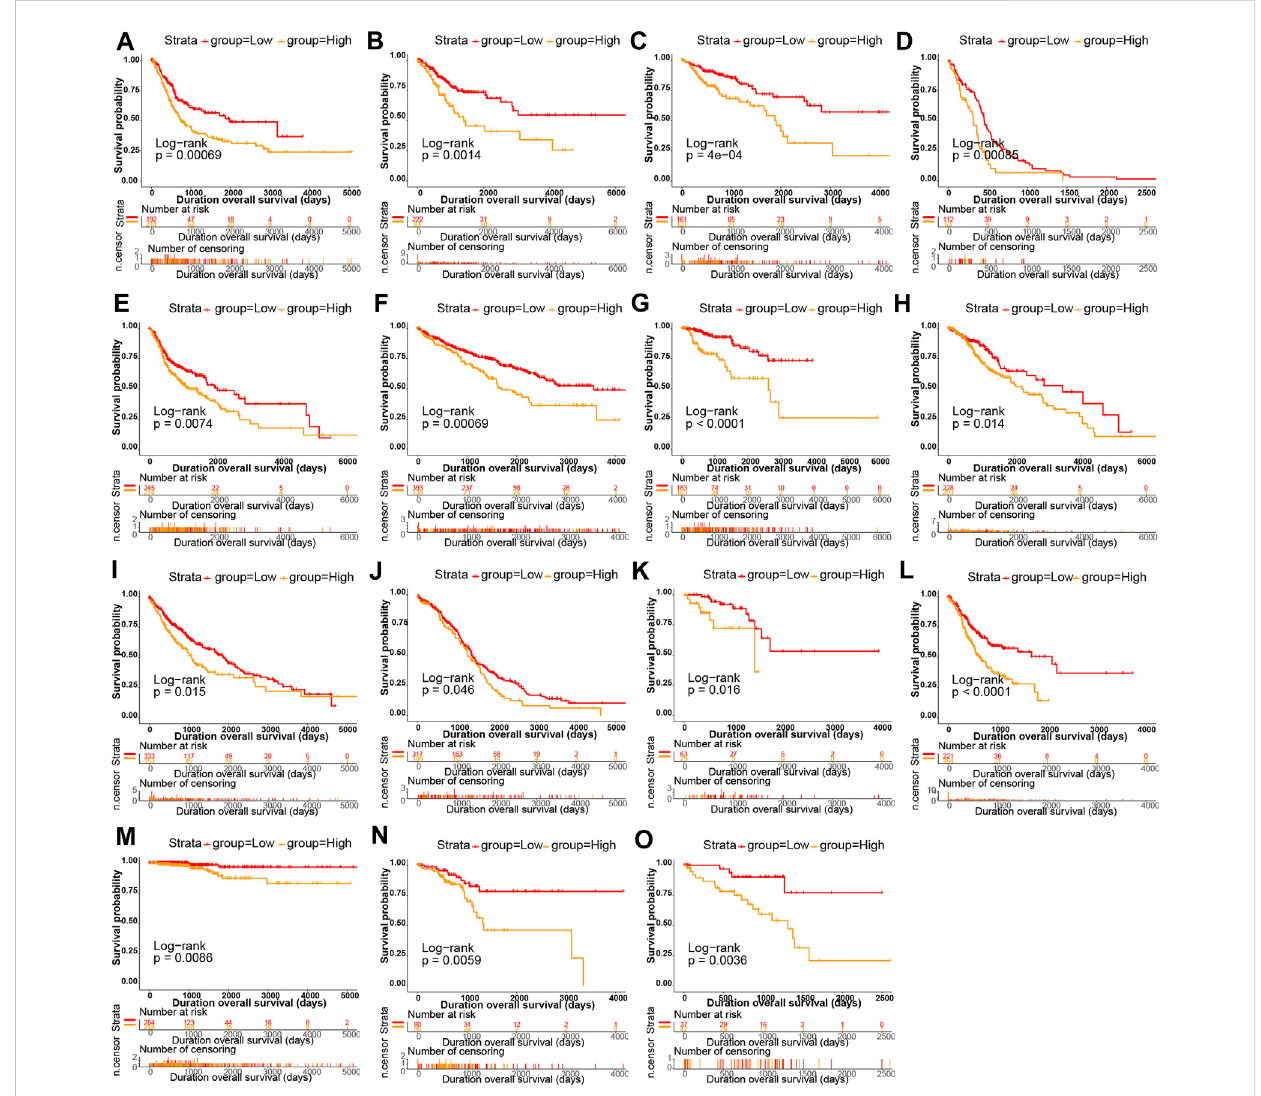
FIGURE 3 The relationship of P4HA3 expression with patients ’ overall survival (OS). Kaplan – Meier survival analysis of OS between high- and low-expression groupsof P4HA3 in (A) ACC (B) BRCA, (C) CESC (D) CHOL, (E) GBM (F) HNSC, (G) KICH (H) KIRC, (I) LAML (J) LGG, (K) LIHC (L) LUAD, (M) LUNG (N) MESO, and (O)